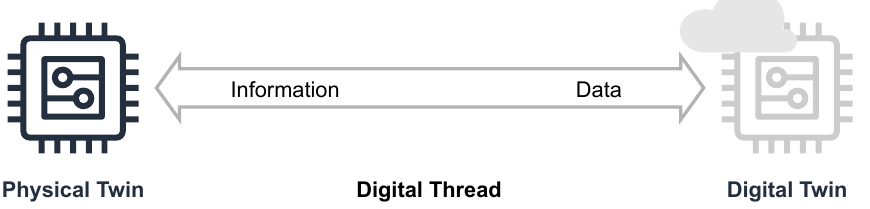
Figure 1. Concept of Digital Twins According to